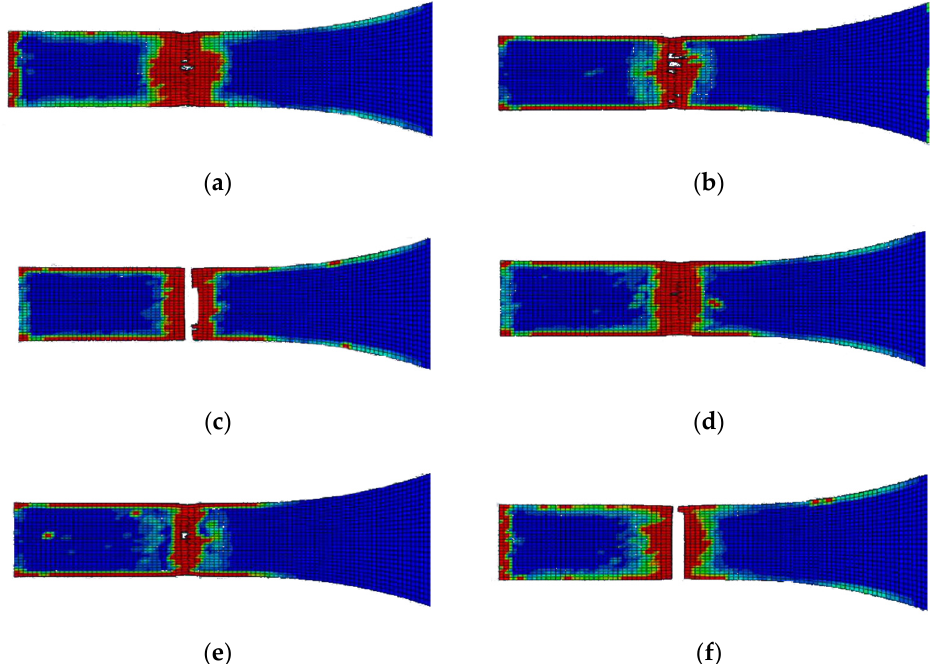
Figure 10. Delamination of each layer of laminate A after failure; ( a ) 1st interface; ( b ) 2nd interface; ( c ) 3rd interface; ( d ) 4th interface; ( e ) 5th interface; ( f ) 6th interface.